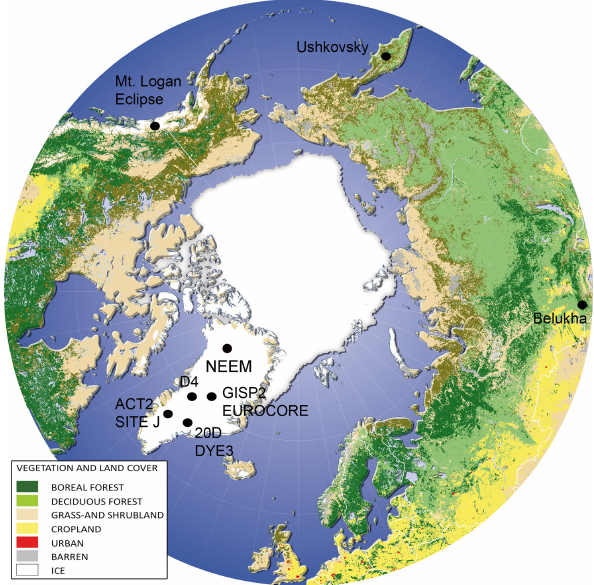
Figure 1. NEEM camp position and representation of boreal vege- tation and land cover between 50 and 90 ◦ N. Modified from the Eu- ropean Commission Global Land Cover 2000 database and based on the work of cartographer Hugo Alhenius UNEP/GRIP-Arendal (Alhenius,